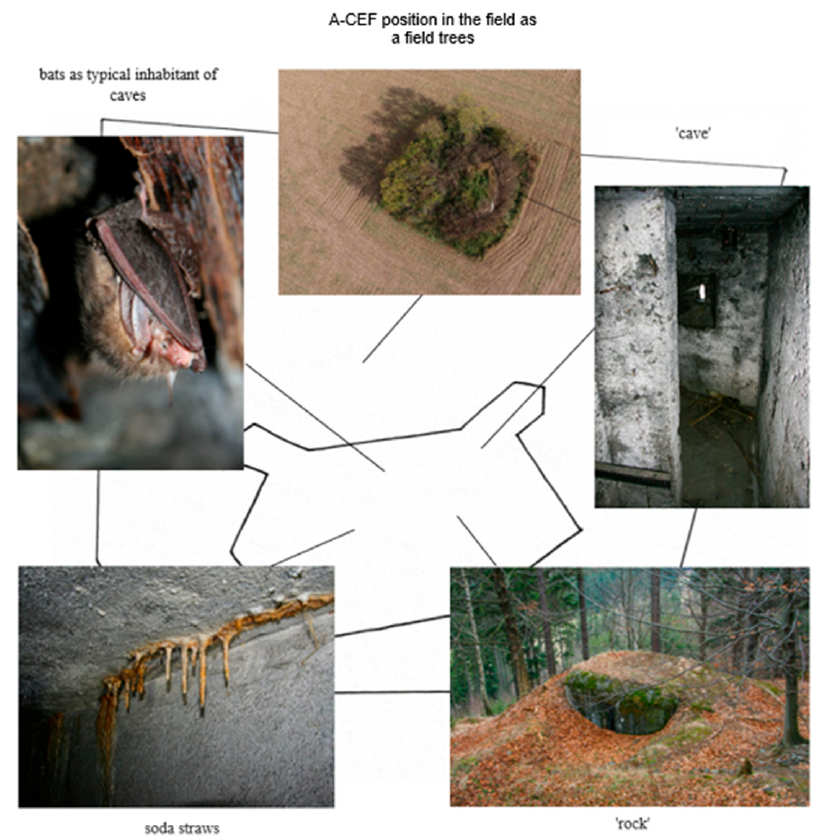
Figure 5. Different points of view of individual functions of A ‐ CEFs.